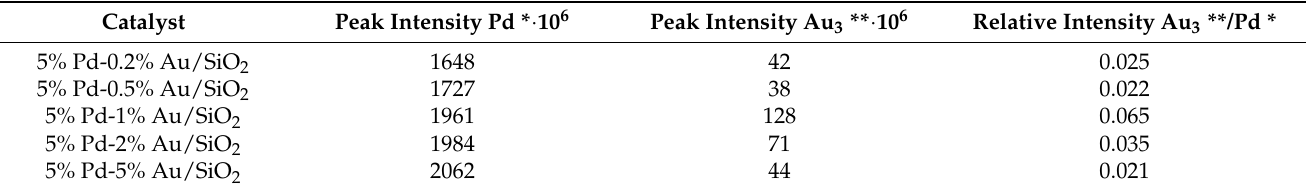
Table 2. Intensity of the positive ion peaks 106 Pd and negative ions Au 3 obtained using the secondary ion mass spectrometry (ToF-SIMS) for bimetallic catalysts Pd-Au/SiO 2 reduced in H 2 at 300 ◦ C. Reprinted from ref. [29].